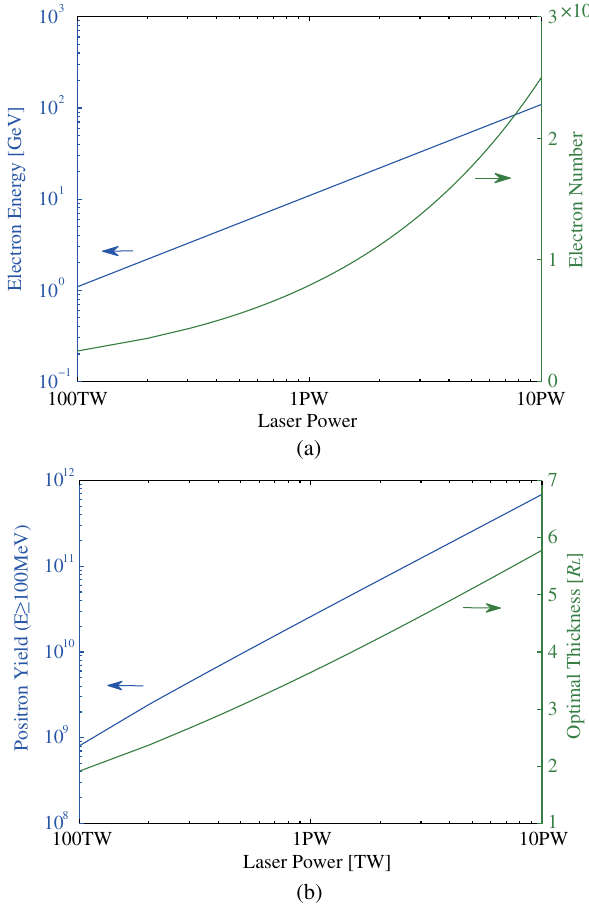
FIG. 3. (a) Electron energy (blue line) and total electron yield (green line) with different laser power under optimal LWFA conditions based on W. Lu ’ s theory. (b) Maximum positron yield with energy beyond 100 MeV (blue line) and corresponding optimal converter thickness (green line) as functions of driven laser